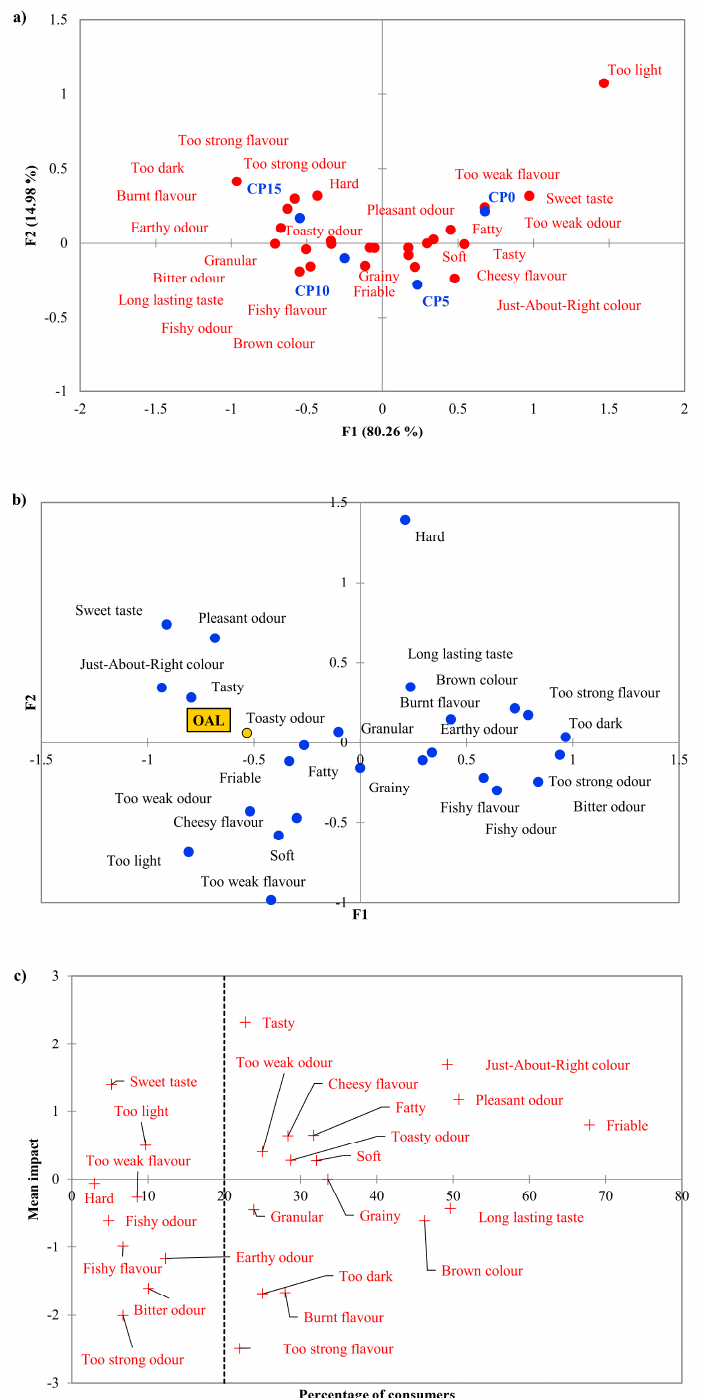
Figure 2. Visualized results of the check-all-that-apply (CATA) analysis of the four biscuit samples. ( a ) Correspondence analysis of the used CATA terms and the four samples. ( b ) Principal Coordinate Analysis of the used CATA terms and Overall Liking (OAL) scores. ( c ) The mean impact of the marked attributes on overall liking, visualized with the percentage of consumer who marked those attributes (dashed line). CP0—0 g / 100 g house cricket containing flour mixture-based biscuit, CP5—5 g / 100 g house cricket containing flour mixture-based biscuit, CP10—10 g / 100 g house cricket containing flour mixture-based biscuit, CP15—15 g / 100 g house cricket containing flour mixture-based biscuit. OAL stands for overall liking. Only those 25 CATA terms are shown that significantly di ff erentiate the four